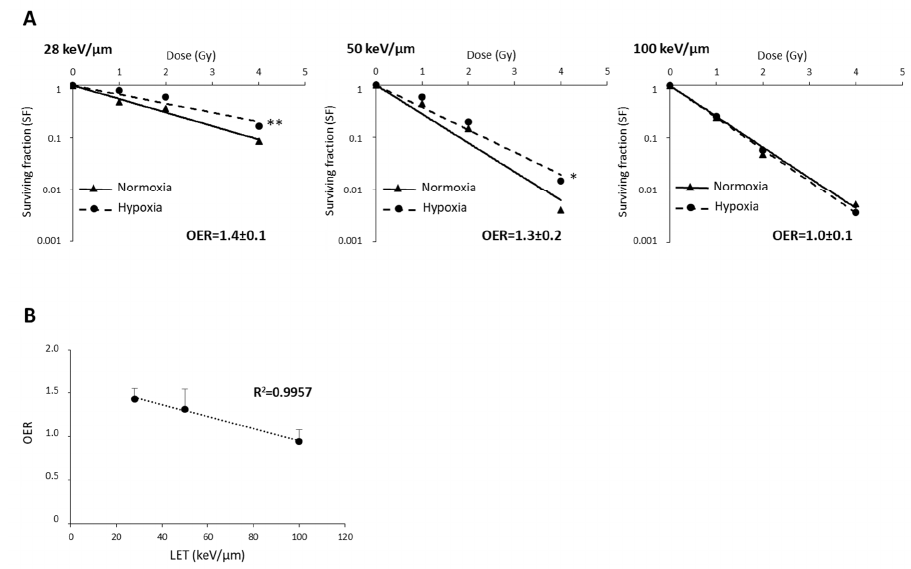
Figure 4. Evaluation of ERK activation after carbon ion irradiation in glioblastoma (GB) cells cultured in normoxic and hypoxic conditions. ( A and B ) Representative western blots of phospho-ERK1/2 and total ERK at 24 h after carbon ion irradiation (4 Gy, C ions 28 keV/µm) under normoxic (21% O 2 ) or hypoxic conditions (1% O 2 ) in U251 cells (A-top) and GL15 cells (B-top). Quantitative analyzes of the ratio P-ERK/Total ERK for U251 cells (A-bottom) and GL15 cells (B-bottom). Mean ± SD, N = 3 different samples for each condition. Fisher’s LSD post-hoc test after a significant one-way ANOVA: * p < 0.05 and ** p < 0.01.